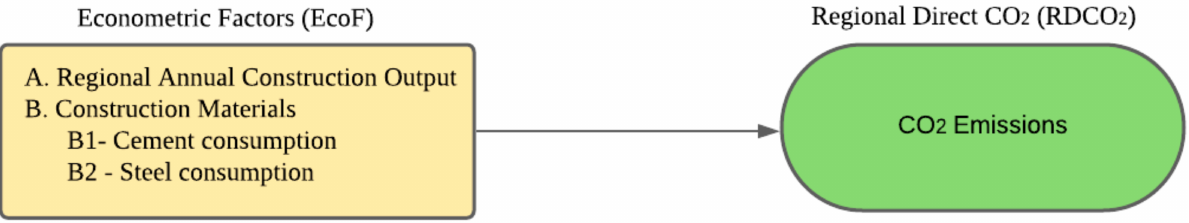
Figure 2. Conceptual EcoF–RDCO 2 econometric direct CO 2 emission model in China’s construction